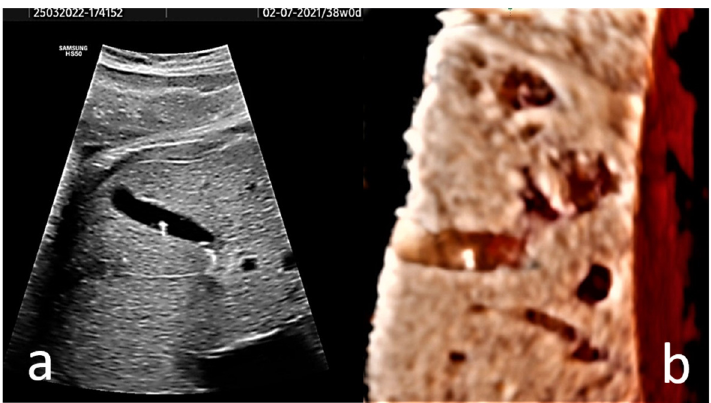
Figure 2. ( a ) Axial section of the gallbladder of a 38 gestational weeks fetus. The hyperechogenic spots are well-defined and do not present distal shadowing; instead they show comet tail artifact. ( b ) A 3D rendered image of the fetus’ gallbladder is provided. A Voluson S8 ultrasound machine with abdominal convex array volume probe RAB6-RS (GE Healthcare, Zipf, Austria) was used.